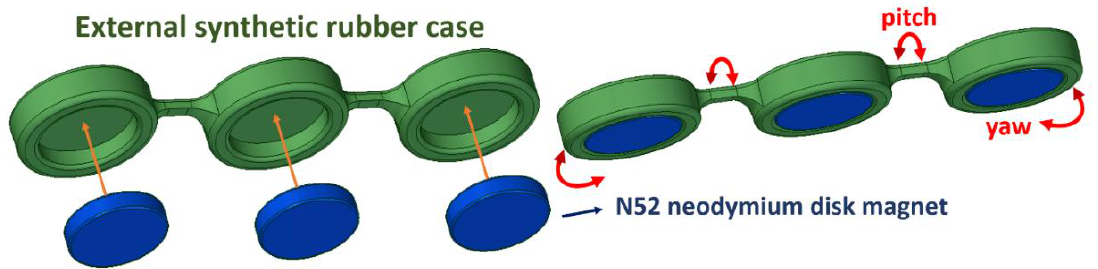
Figure 22. Synthetic rubber casing for the external disk magnets, preventing collision and allowing for flexibility and a limited range of rotation of each disk magnet with respect to the neighboring disk magnet.